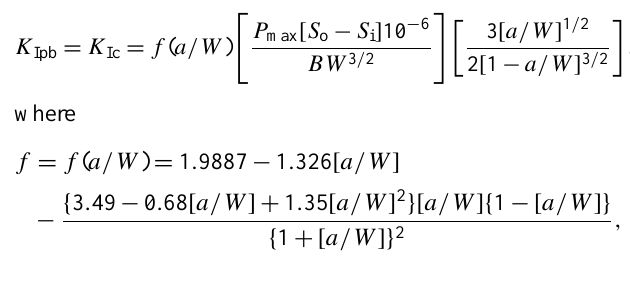
Figure 5. Cross section of ice core showing the sample location Figure 8. Representative force and displacement data as a function pattern. of time during a fracture experiment. The vertical thin black line reprents the time at failure.